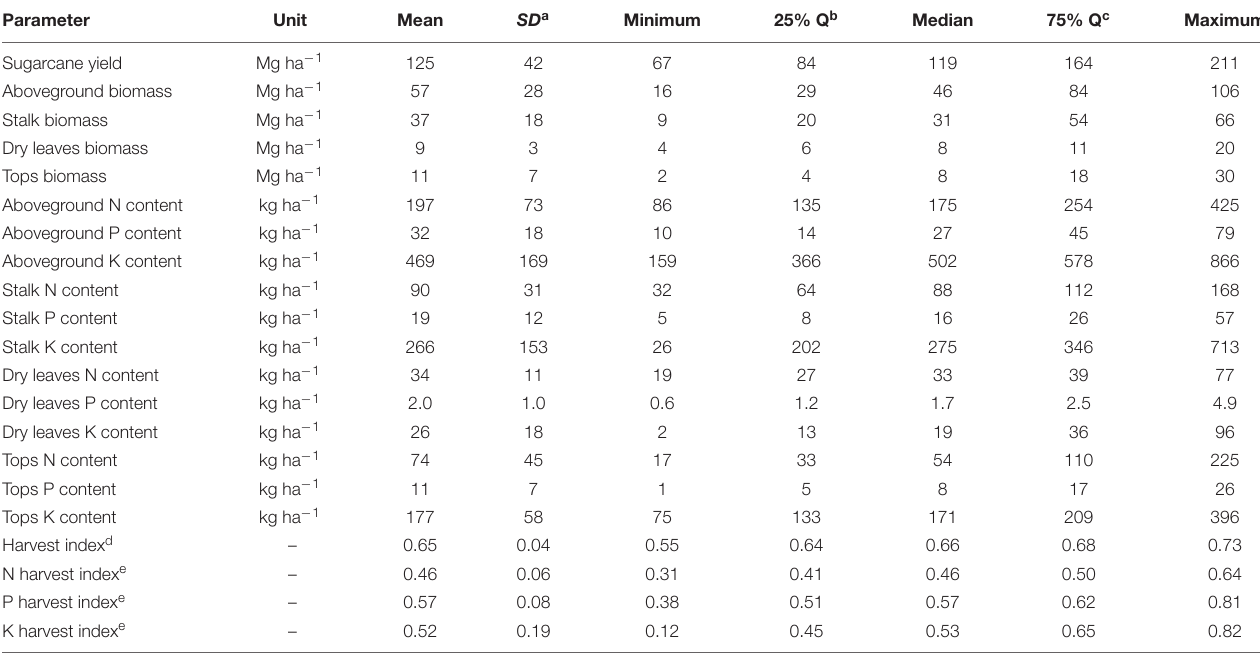
TABLE 2 | Descriptive statistics related to sugarcane yield, aboveground biomass and its components (stalks, dry leaves, and tops), content of nitrogen (N), phosphorus (P), and potassium (K) allocated in each plant component, HI and HI of N, P, and K for sugarcane (first ratoon cycle) across three sites located in the Southeast region of Brazil ( n =